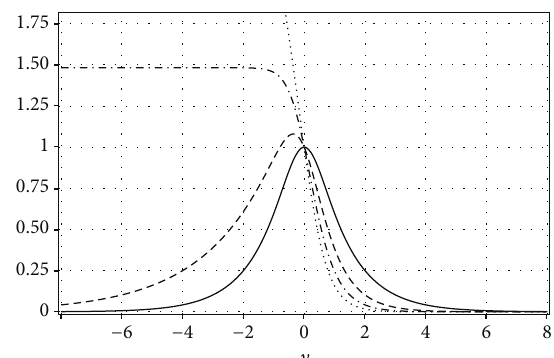
Figure 1: The potential given by (8) for 𝑐 = 0 (black line), 𝑐 = 2/3 (dashed curve), 𝑐 = 4/3 (dot-dashed line), and 𝑐 = 2 (dotted line).